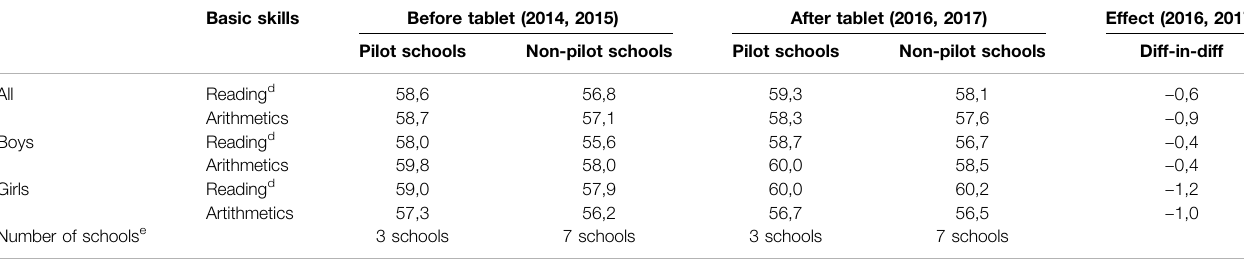
TABLE 6 | Difference-in-difference analysis of average test results, ninth grade (group